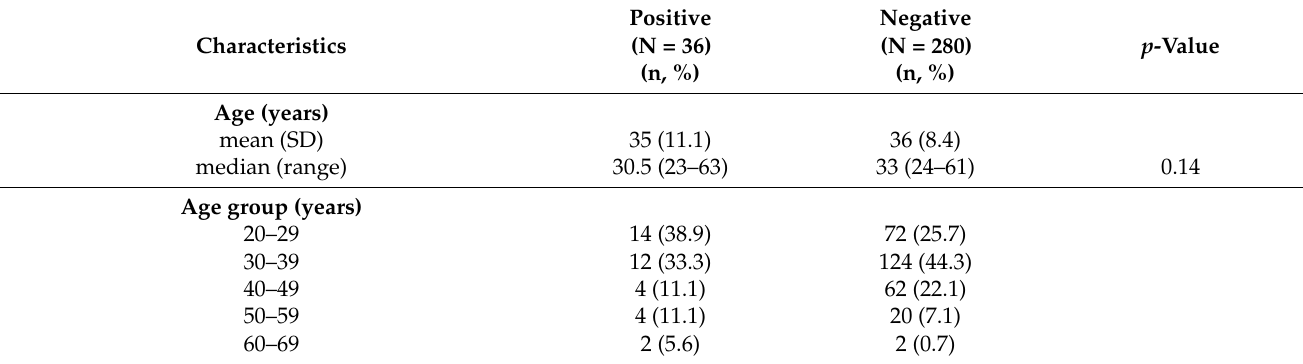
Table 2. Comparison of characteristics and signs and symptoms of HCWs suspected to have COVID-19 who tested positive and negative for the additional respiratory viral panel